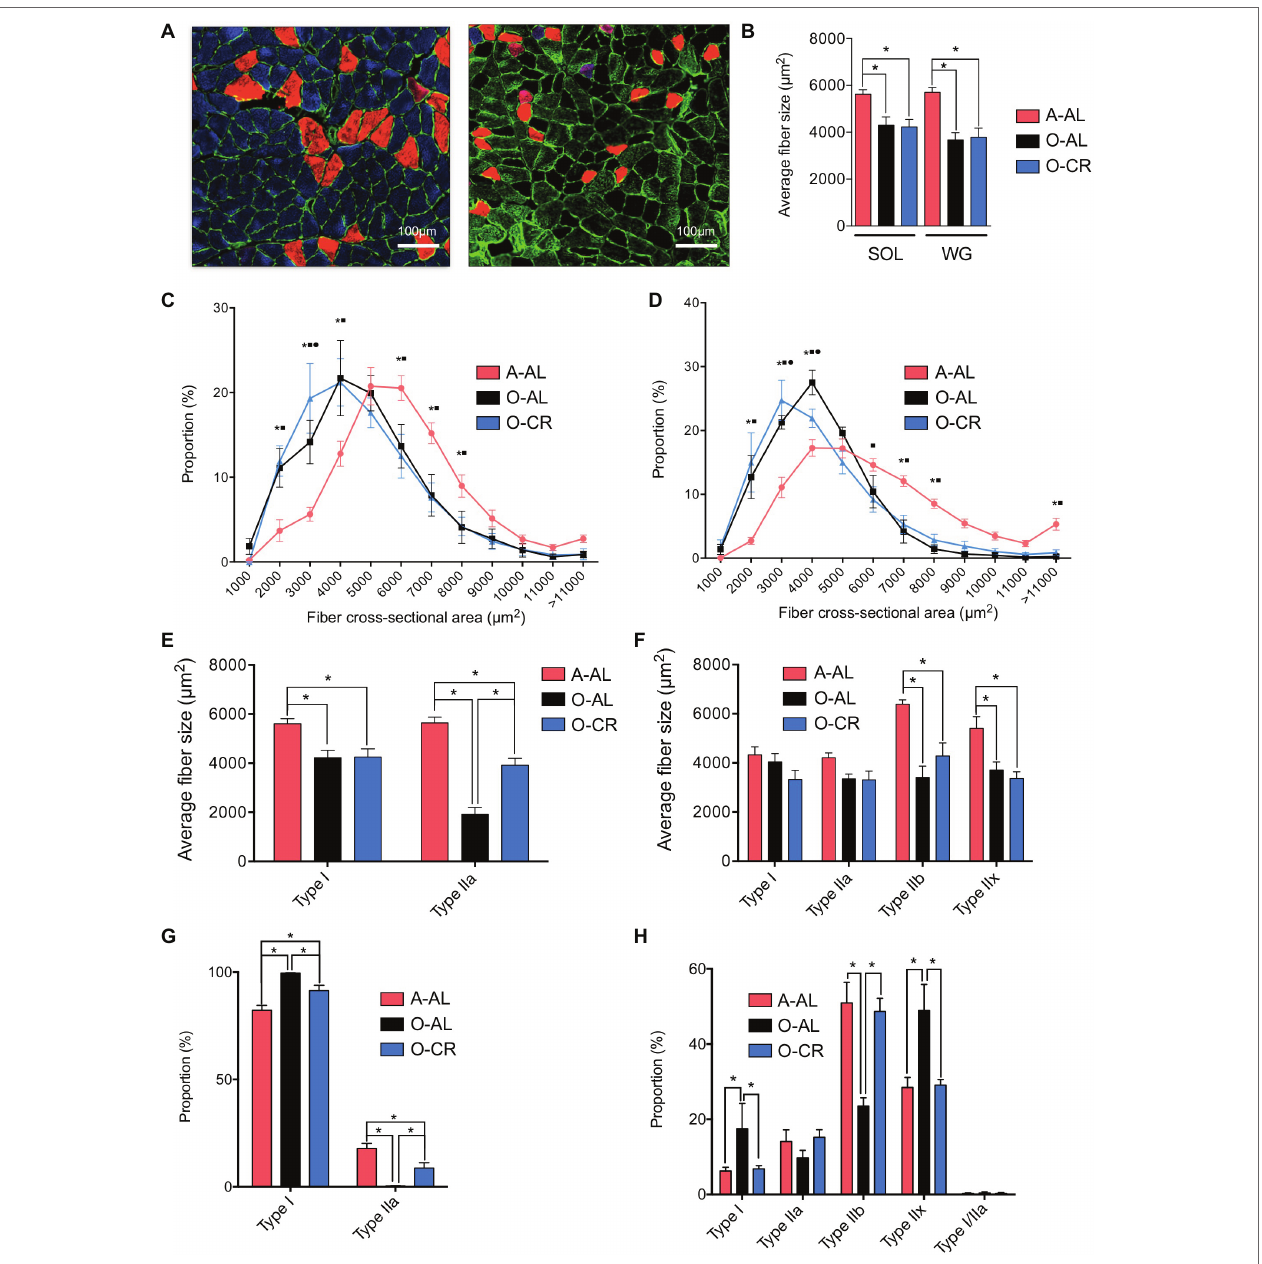
FIGURE 2 | Effect of aging and caloric restriction on fiber cross-sectional area and fibers type. (A) Representative immunolabeling of type I (blue), type IIa (red) and type IIb (green) myosin heavy chains (MHCs) performed on muscle cross section of SOL (left) and GAS (right) muscles from A-AL. (B) Average fiber size of the SOL and WG of A-AL, O-AL, O-CR rats. (C) and (D) Fiber size distribution in the SOL (C) and GAS (D) of A-AL, O-AL and O-CR rats. (E) and (F) Muscle fiber type composition in SOL (E) and GAS (F) of A-AL, O-AL and O-CR rats. Muscle fiber type proportion in SOL (G) and GAS (H) of A-AL, O-AL and O-CR rats. Scale bars: 1000 μm. Data in graphs are presented as Mean ± SEM. N = 4 to 9 per group. *: p < 0.05. Data in graphs C and D. *: p < 0.05 A-AL vs O-AL; ■ : p < 0.05 A-AL vs O-CR; •: p < 0.05 O-AL vs